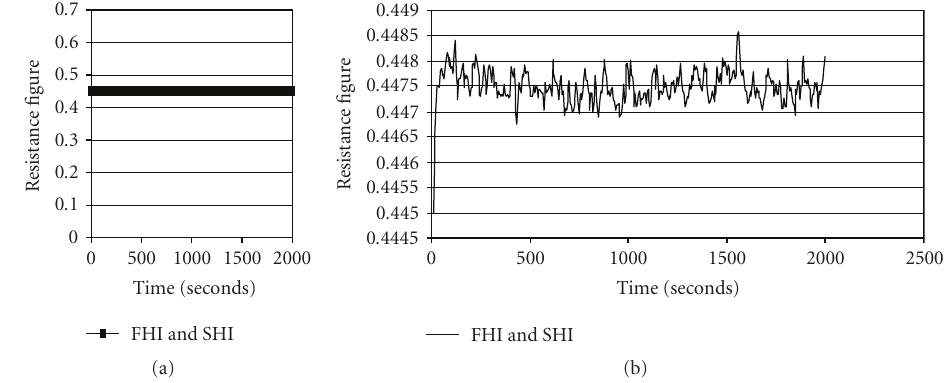
Figure 2: The e ff ect of SHI on resistance figure: (a) compressed scale, (b) detailed scale.